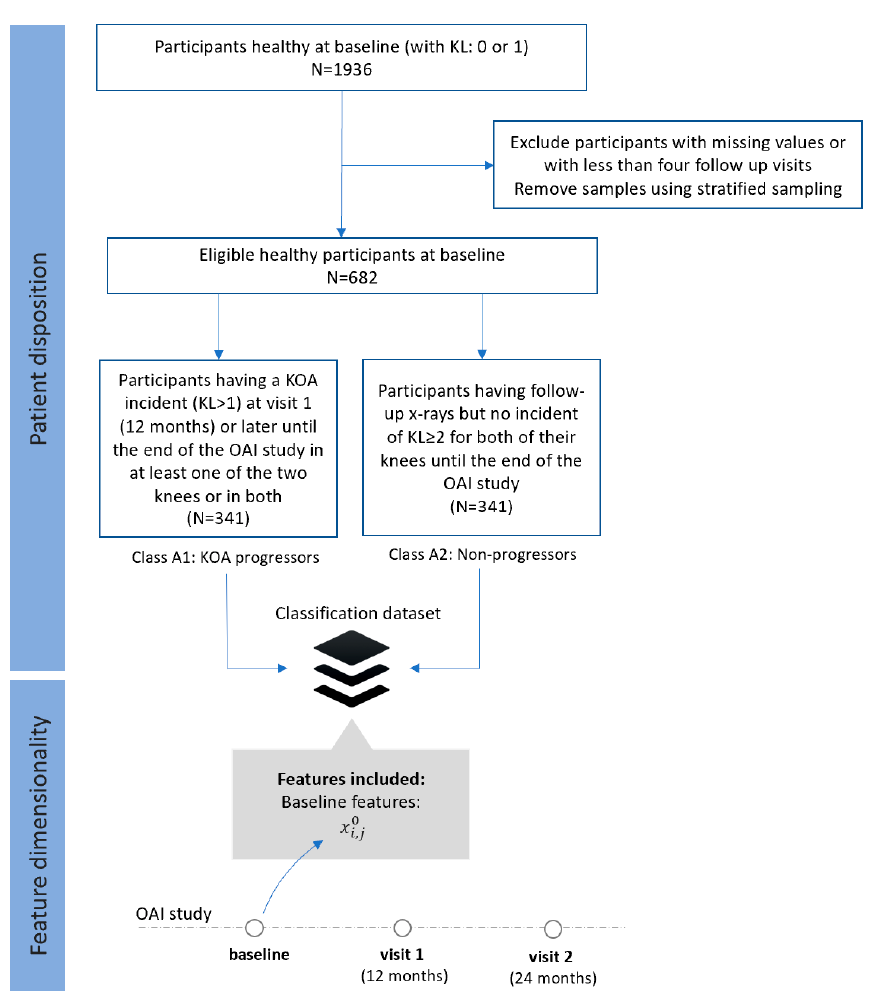
Figure 1. Flow chart of study design for dataset A.